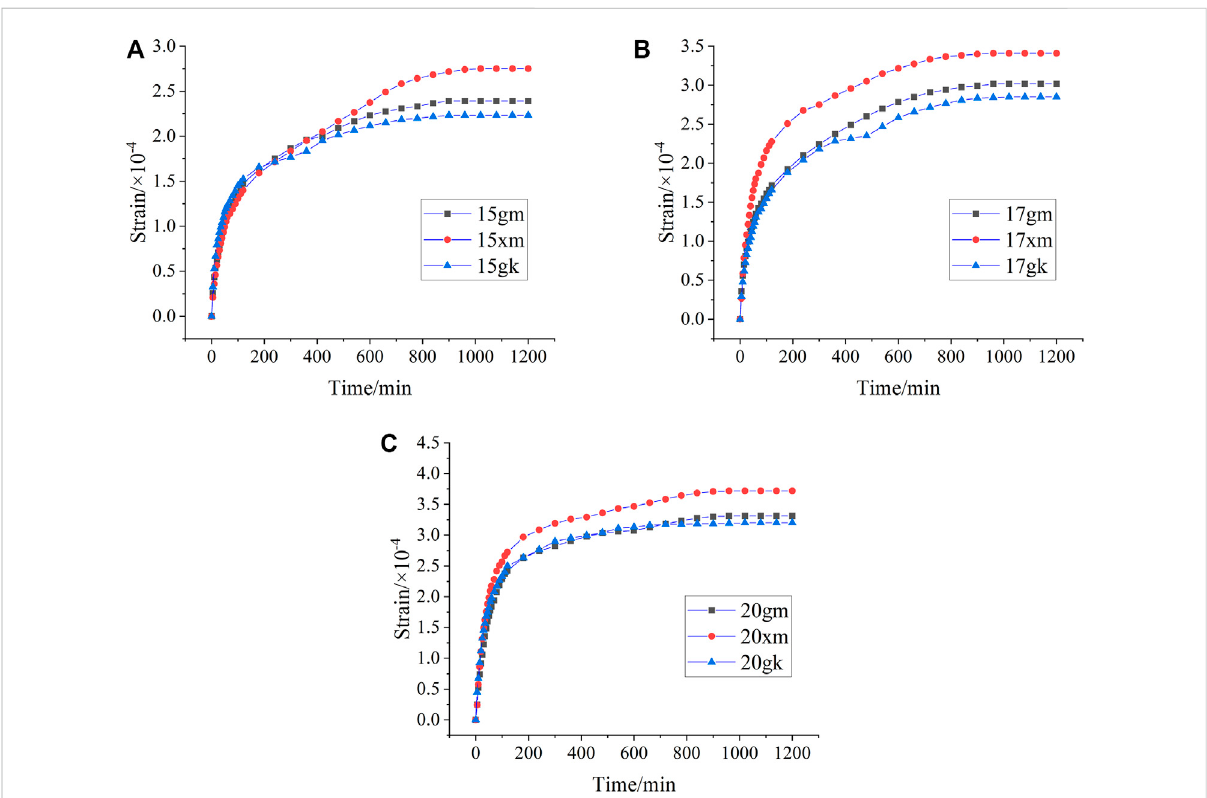
FIGURE 5 Relationship between the temperature shrinkage strain and time (lime – fl y ash content unchanged): (A) 15%; (B) 17%; and (C) 20%.